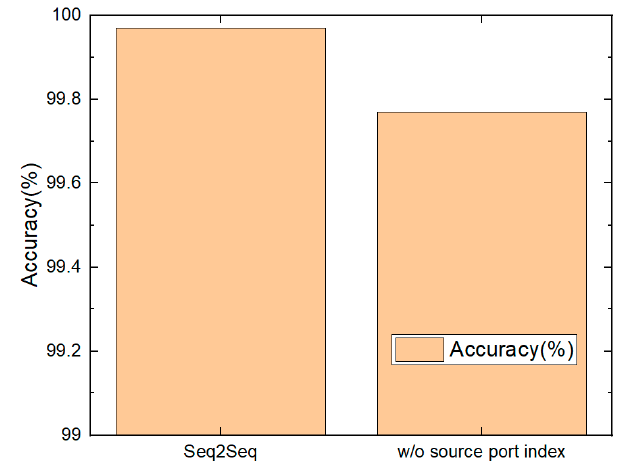
Figure 14. Accuracy when a source port index is not used.